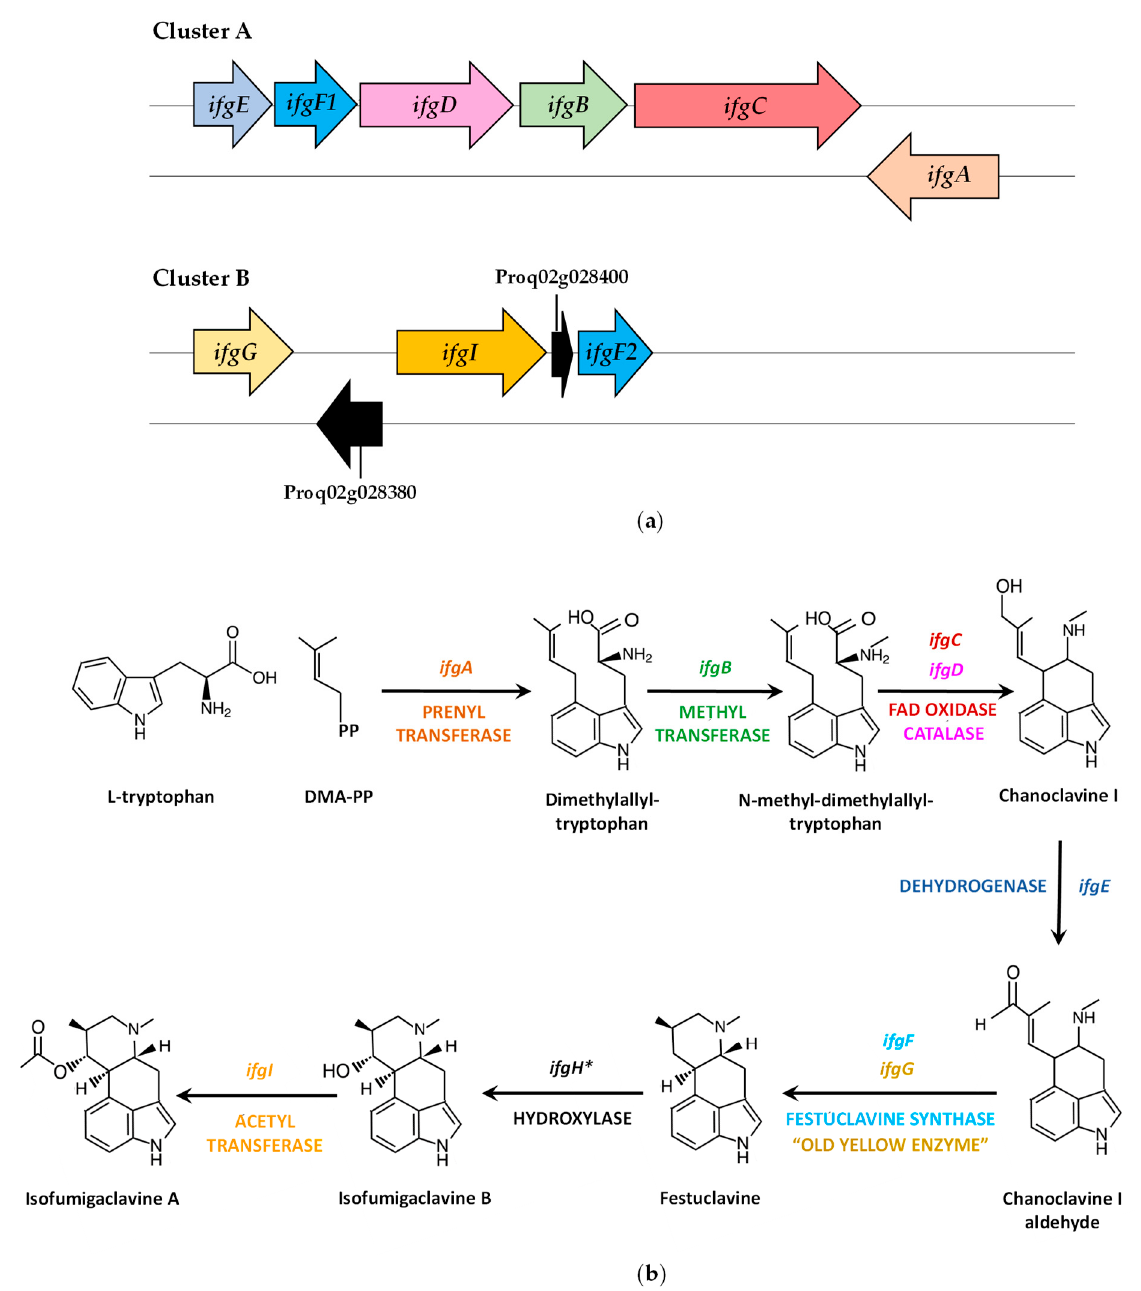
tion of the Isofumigaclavine A biosynthetic gene cluster (Figure 3a, Table 2) and elucidation of the biosynthetic pathway in P. roqueforti [54] (Figure 3b).